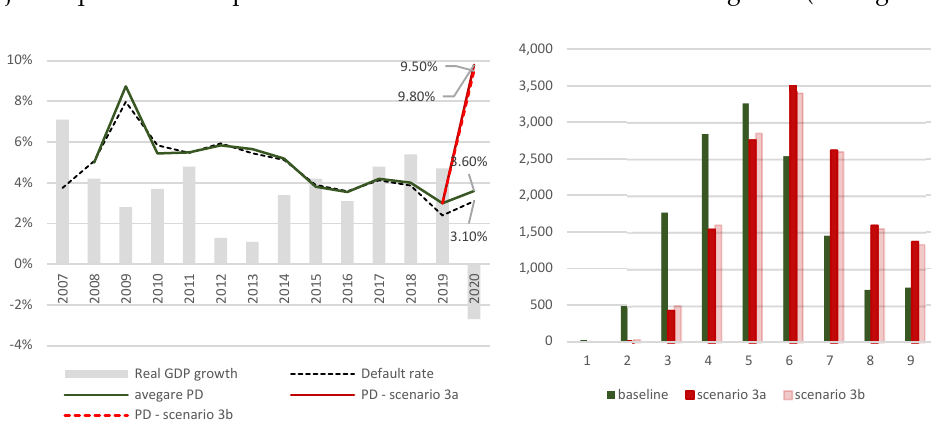
Figure 10. PD and rating in stress scenarios 3a and 3b.